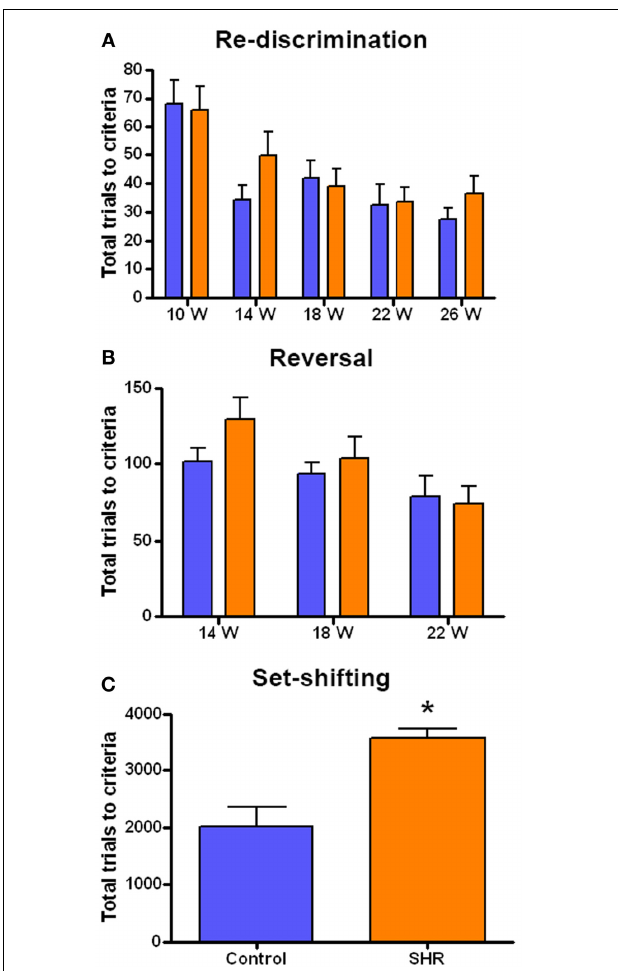
FIGURE 3 | Number of trials to reach criteria in the behavioral tests. (A) Discrimination (10 weeks) and re-discrimination (14, 18, 22, and 26 weeks); (B) reversal learning, and (C) set-shifting test. Blue bars represents control animals ( n = 8) and orange bars SHR ( n = 8). Data is represented as mean ± s.e.m. Asterisks indicate differences between groups (Bonferroni test). ∗ P < 0 . 01.